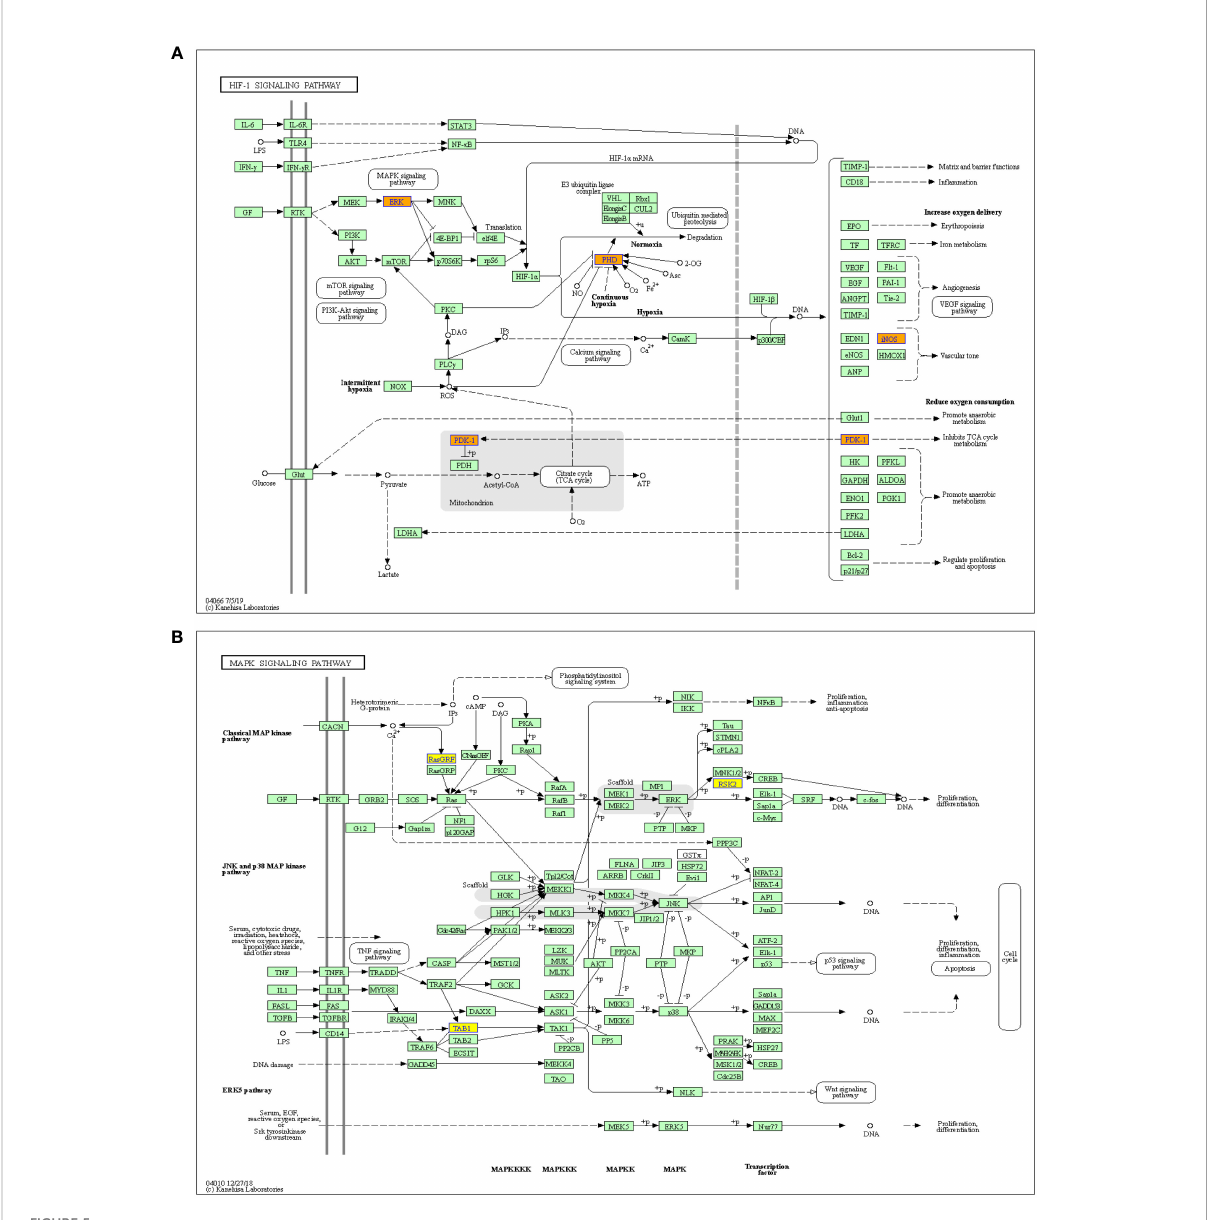
FIGURE 5 Pathway analysis of signi fi cantly altered m 6 A-modi fi ed circRNAs between the in situ and the peritoneal metastasis lesions of the HGSCO patients. (A) The up-regulated m 6 A-modi fi ed circRNAs involved in HIF-1 pathway. (B) The down-regulated m 6 A-modi fi ed circRNAs play important roles in MAPK signaling